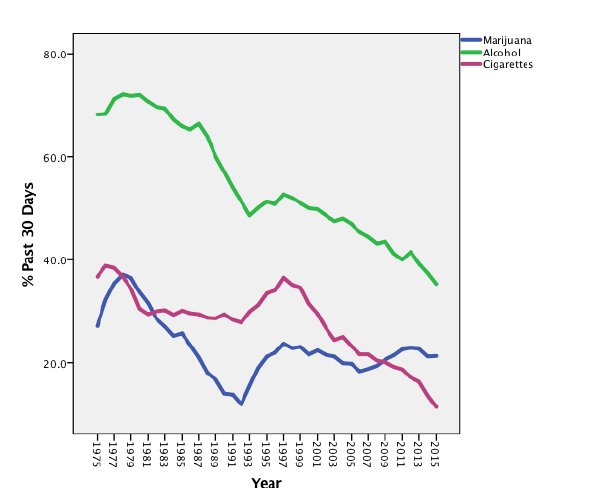
Figure 1. Rates of drug use by US high school 12 th grad- ers based on the Monitoring the Future study. Source: Johnston, O’Malley, Miech, Bachman and Schulenberg